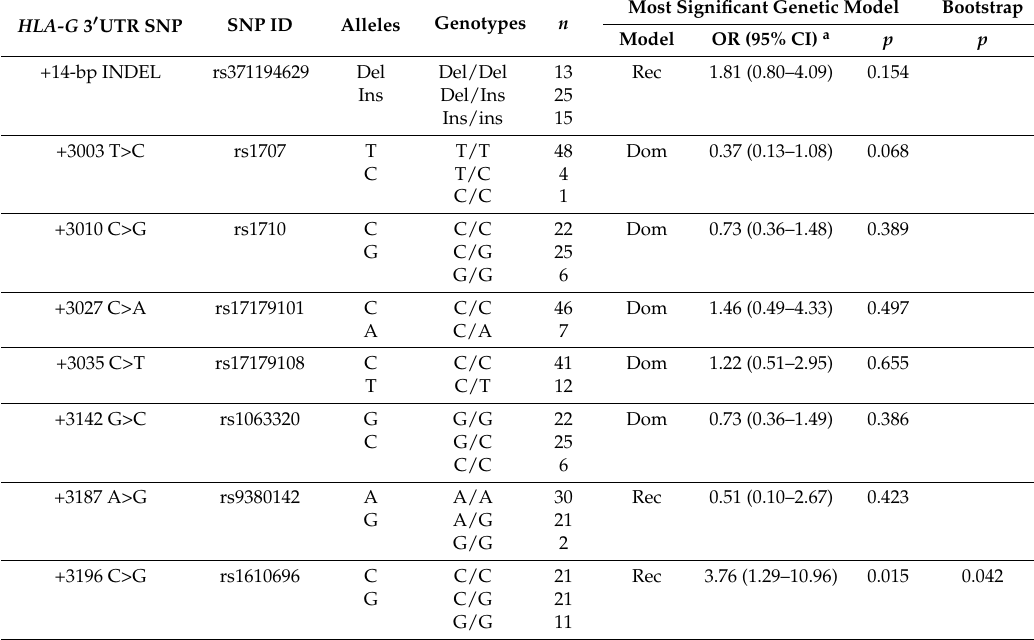
Table 4. Associations between HLA-G 3 (cid:48) UTR SNPs and G3-4 neutropenia